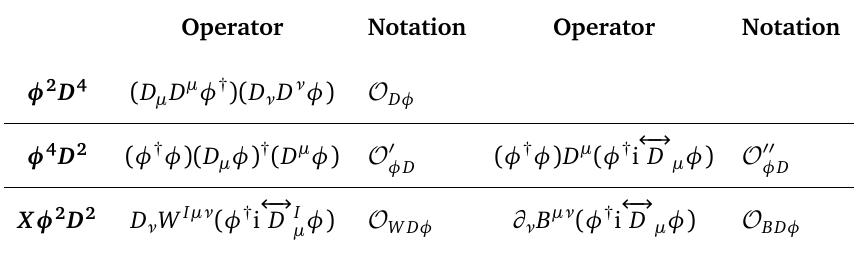
Table 2: Independent dimension-six bosonic operators involving the Higgs which are redundant with respect to the Warsaw basis. We adopt the notation of Ref. [ 52 ]